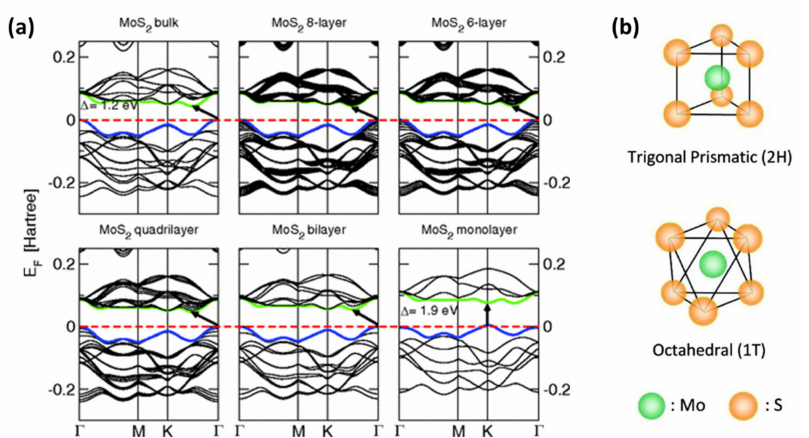
Figure 4. ( a ) The band structures of MoS 2 from bulk to monolayer MoS 2 calculated at the DFT- PBE level. The horizontal dashed lines indicate the Fermi level. The arrows indicate the smallest value of the band gap (direct or indirect) for a given system. The green and blue lines represent the conduction and valence band edges, respectively [146]. ( b ) Structure of 2H- and 1T-MoS 2 [46]. Figures reproduced with permission from Ref. [146] copyright © 2011 American Physical Society, and Ref. [46] copyright © 2011, American Chemical